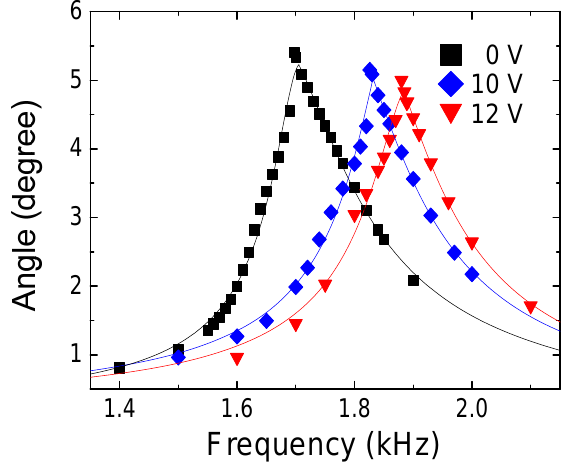
Figure 10. Frequency response change achieved by the shaft ‐ holding type. Data points are fitted with the Lorentzian function. Reproduced with permission from [26]. Table 2. Resonant frequency shifts achieved by the shaft ‐ widening type.